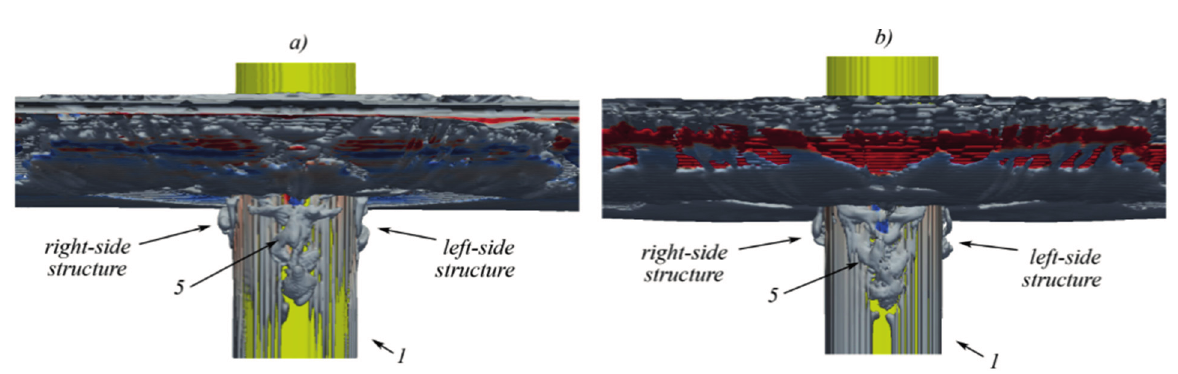
Figure 17. Close-up at the cylinder surface of inviscid-flow structures as obtained from the solution of the Euler equations. Downstream view: ( a